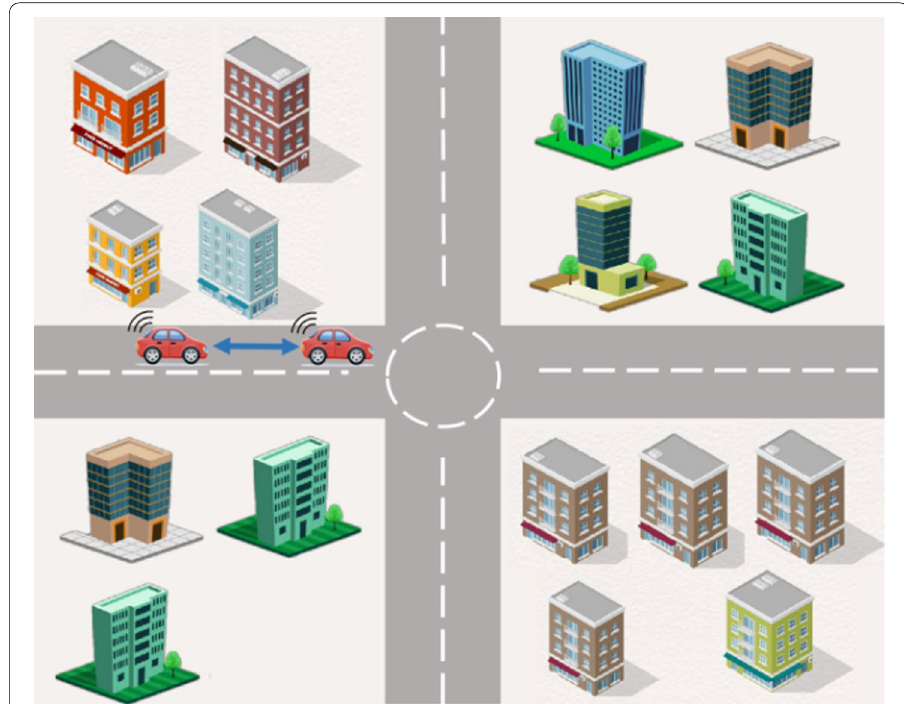
Fig. 16 Schematic diagram of the automobile antenna in the urban environment. The two vehicles loaded with the automobile antenna communicate with each other, and the propagation distance varies with the relative motion